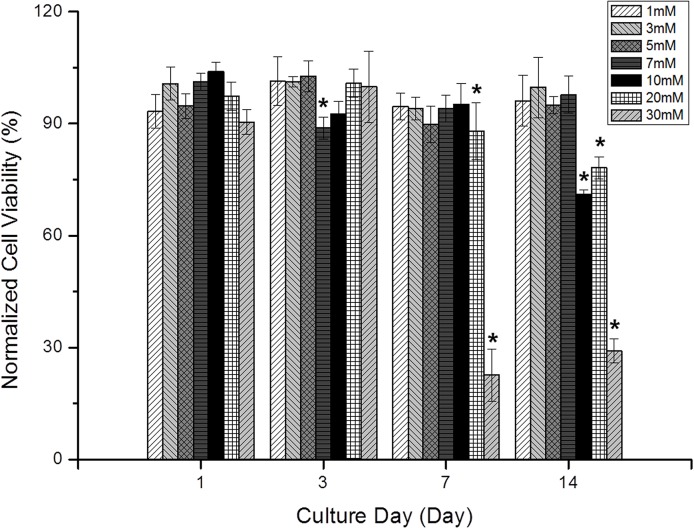
Graphical representation of the normalized changes in cell viability during two weeks of culture with various concentrations of the NMR reference reagent, TSP (n = 10 for each group, *: p<0.05).